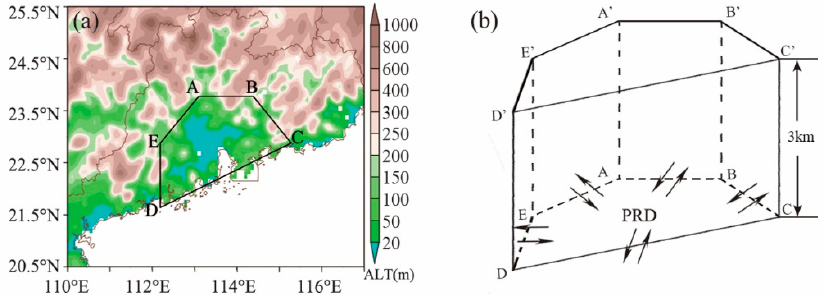
Figure 5. ( a ) Simplified boundary (black solid line) of the PRD region and ( b ) schematic diagram of the trans-boundary transport of pollutants. Table 2. Information on the simplified boundary of the PRD region.